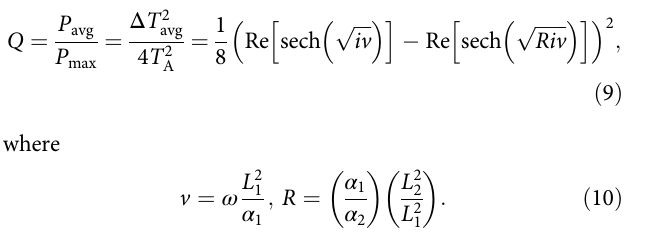
Fig. 3g. The existence of a non-zero intercept in the experimental data is attributed to heat leakage via natural convection at the interface of the thermoelectric material and its ceramic plate (Supplementary Note